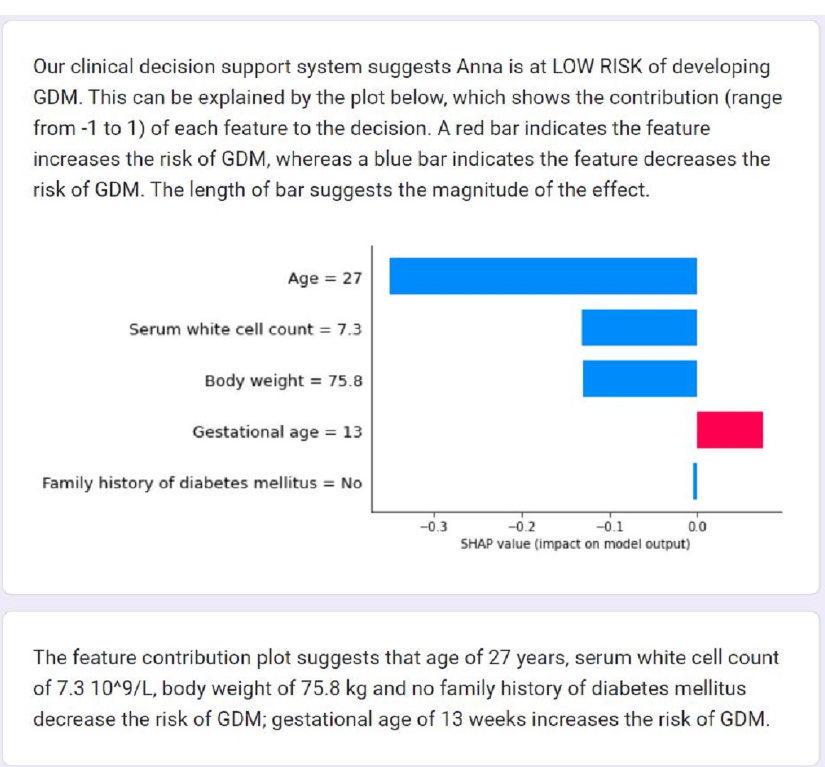
Figure 3. CDSS prediction and explanation by feature contribution for an exemplar